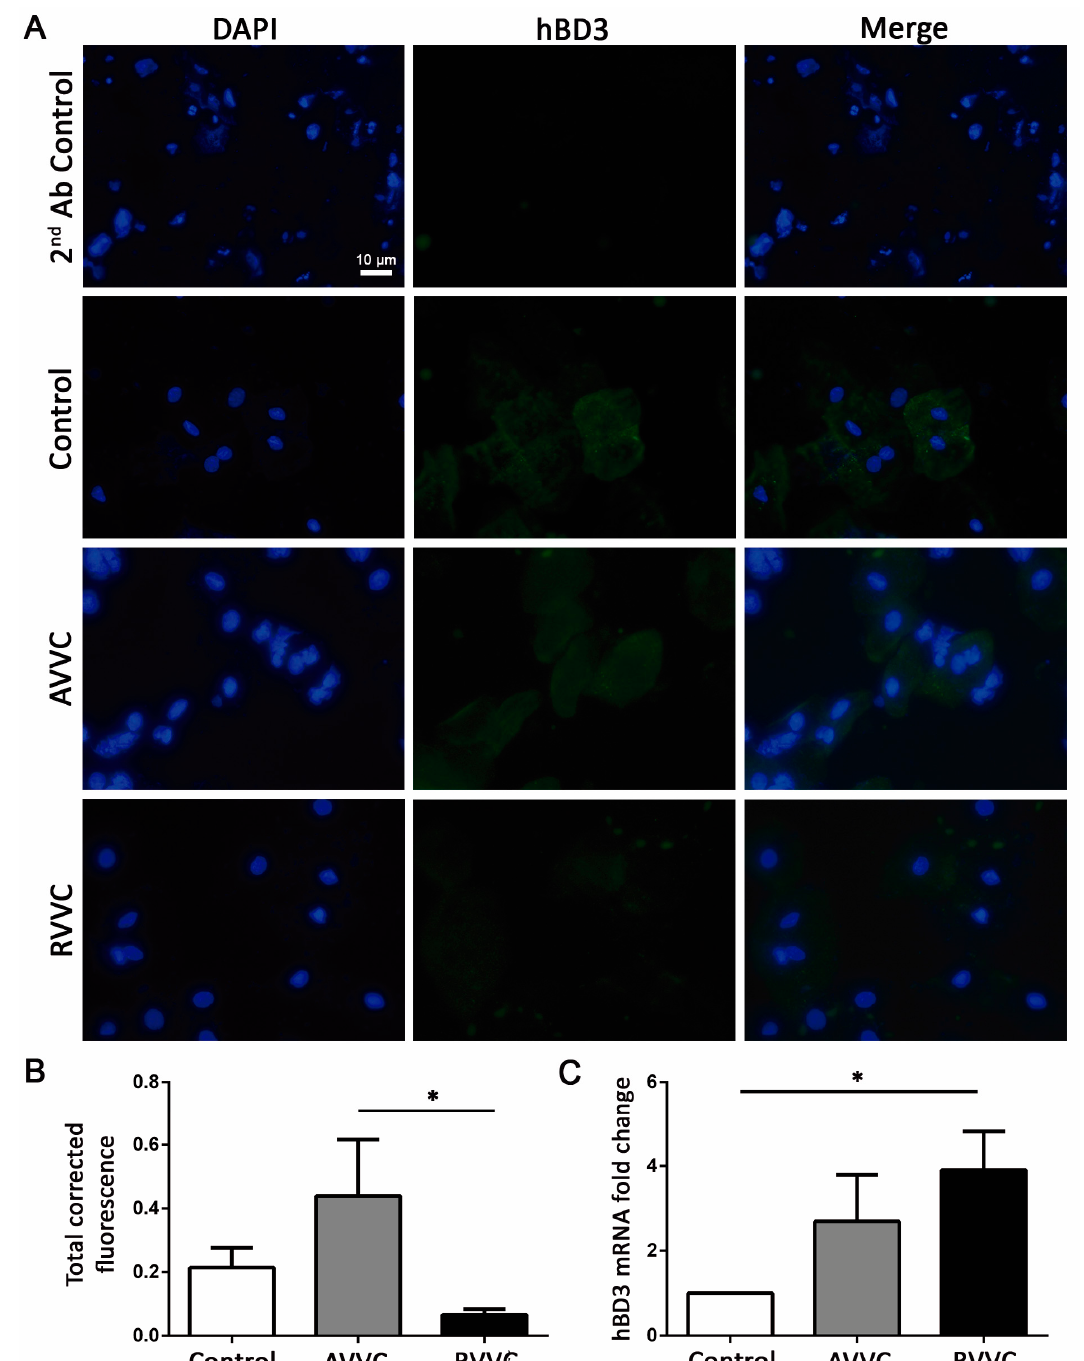
Figure 5. Human Beta Defensin-3 (hBDR3) expression in cells of cervicovaginal lavage. ( A ) Im- munofluorescence of cervicovaginal lavage cytospin samples from Control individuals and patients with AVVC or RVVC. Upper panel (2nd Ab control), cytospin of cervicovaginal lavage from patients with RVVC. Cell nuclei were stained with DAPI (blue), and hBD3 expression is shown in green. Images are shown at × 630 magnification. ( B ) Fluorescence semiquantification analyzed with ImageJ software. The assay could not be performed in all the patients of each cohort due to sample limitations. Mean ± SEM. Control n = 4, AVVC n = 6, RVVC n = 5; * p < 0.05. ( C ) hBD3 mRNA expression by real-time PCR in cervicovaginal lavage cells from Control individuals and patients with AVVC or RVVC. The assay could not be performed in all the patients of each cohort due to sample limitations. Mean ± SEM. Control n = 14, AVVC n = 5, RVVC n = 15; * p < 0.05. ANOVA